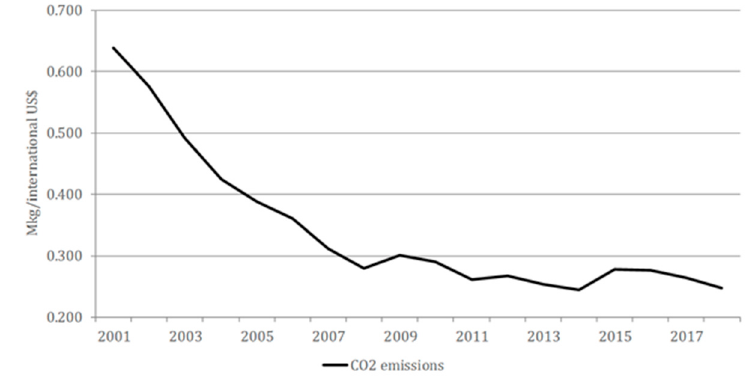
Figure A2. Time evolution of the output variables.